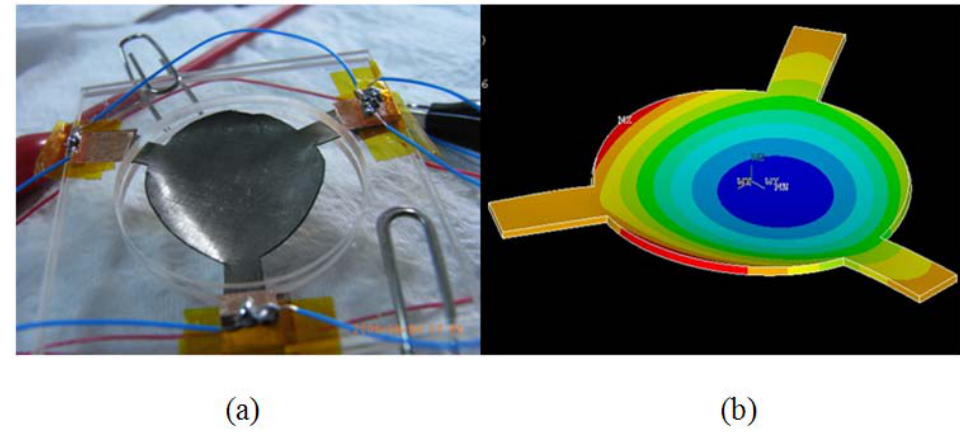
Figure 9. ( a ) Picture of the experimental demonstration of the new deformable mirror; ( b ) The deformation simulated by ANSYS ® .